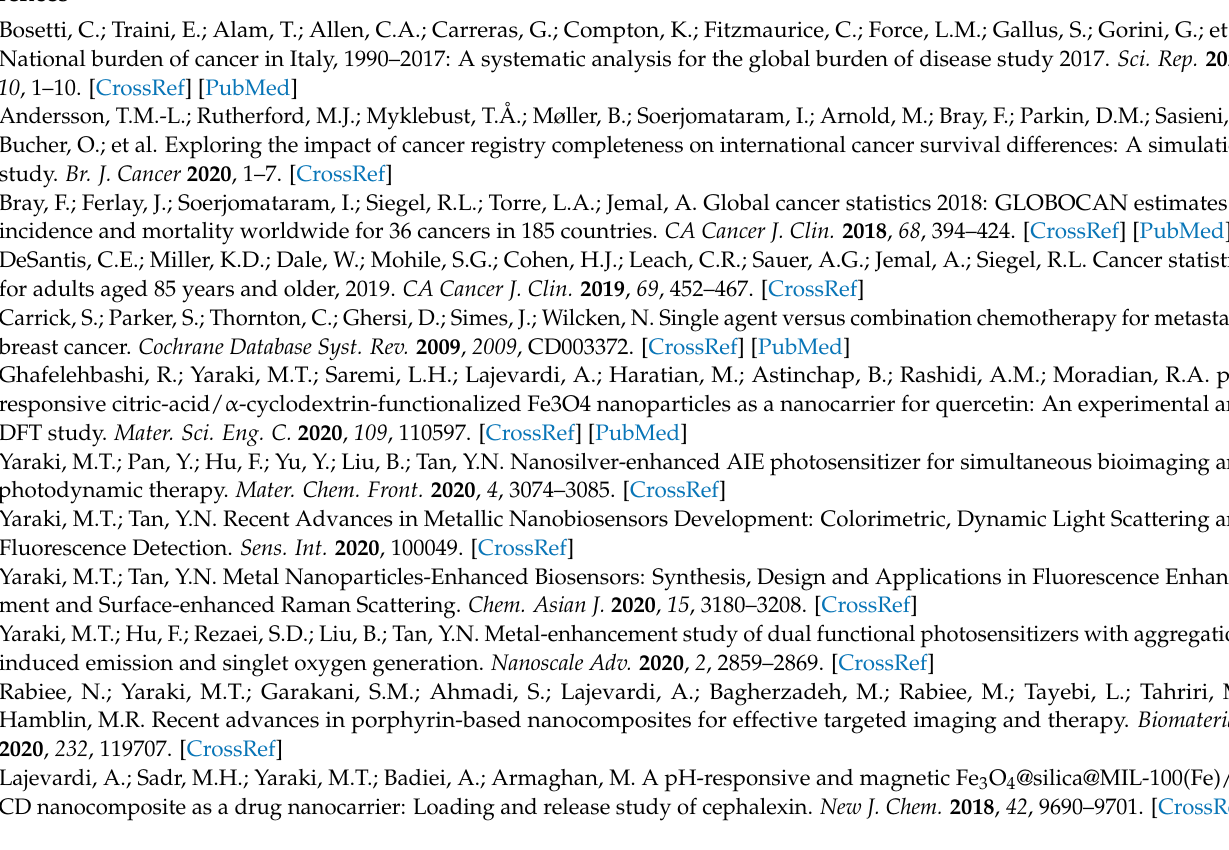
Figure S6. The flow cytometry of SKBR3 cells after treatment with different samples; Lower left panel (Q4): live cells, upper left panel (Q1): necrosis, lower right panel (Q3): early apoptosis, upper right panel (Q2): late apoptosis. Figure S7. The MDA-MB-231 cell cycle analysis of different samples. Figure S8. The SKBR3 cell cycle analysis of different